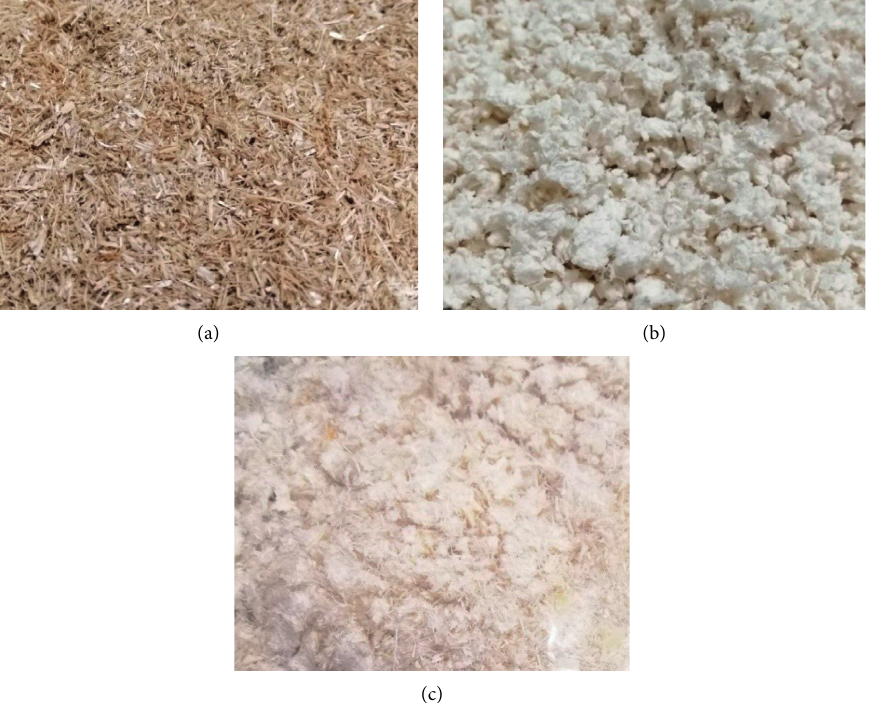
Figure 5: Physical representation of DWS (a), DWS